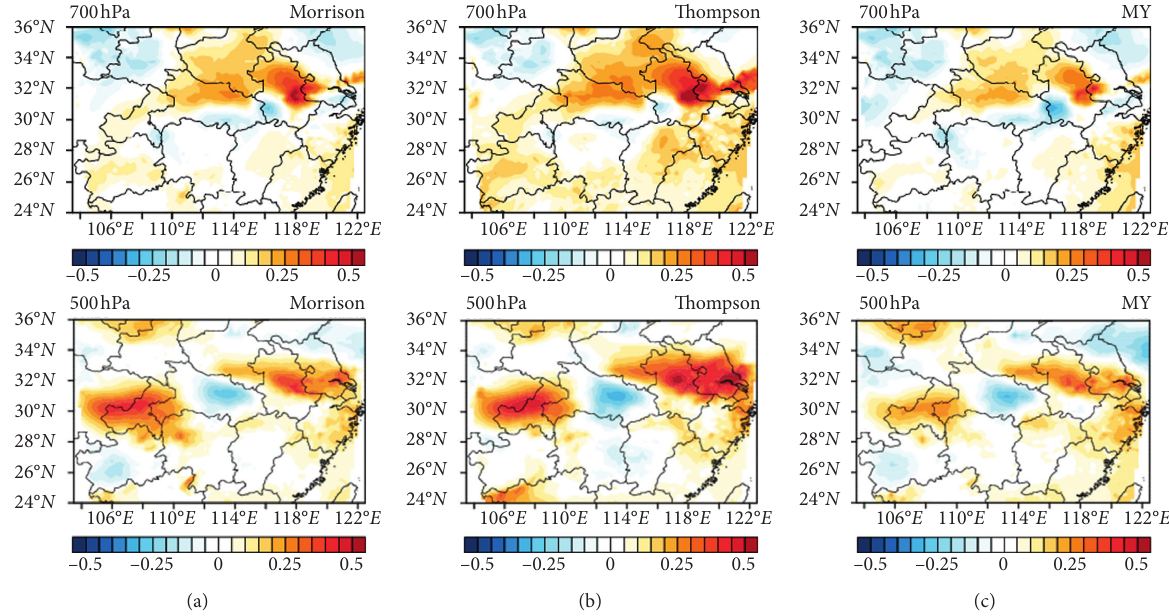
Figure 9: The same as Figure 8 except for the differences between the model output and LAPS product